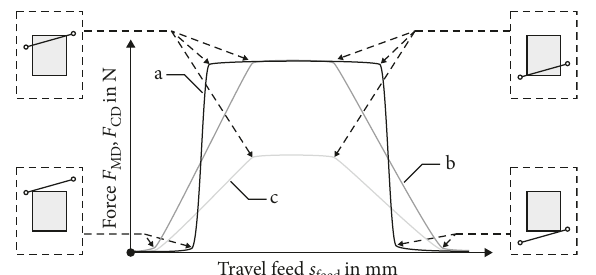
Figure 2: Sketched plot of the calculated force as a function of the feed distance. (a) Describes a typical curve for F MD with λ � 0 ° . (b) Describes a typical curve for F MD with λ � 45 ° . (c) Describes a typical curve for F CD with λ � 45 °